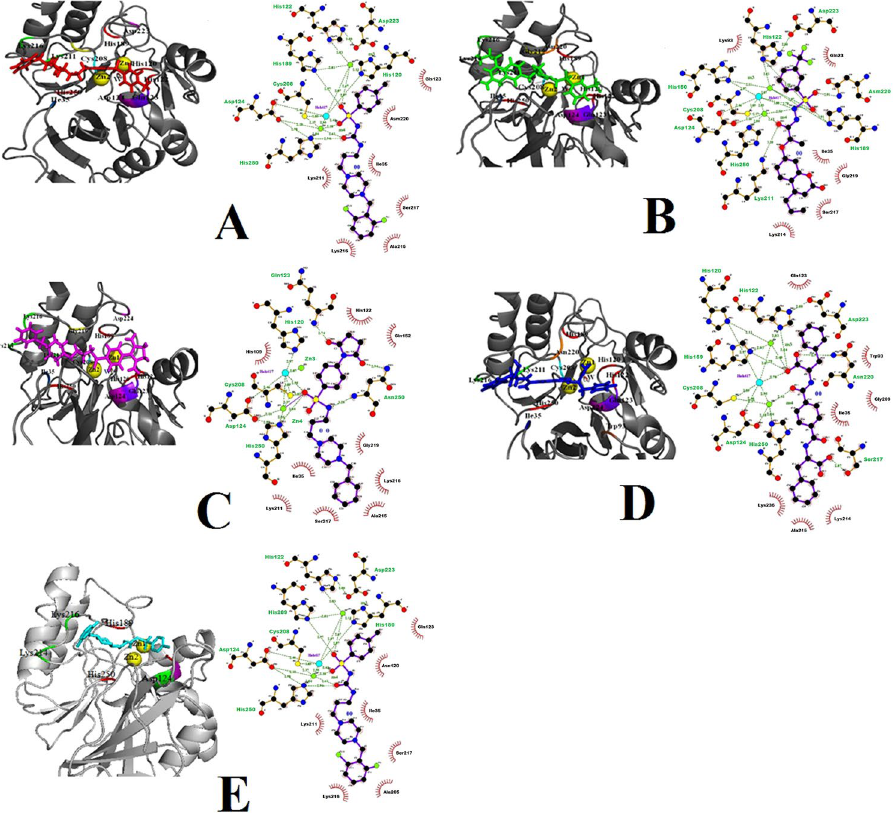
Figure 1. The predicted binding modes between the target enzyme and the compounds. ( A ) BTB02323(M17). ( B ) RJF01991(M21). ( C ) AW01120(M61). ( D ) HAN00044. ( E ) AW01120(M1).